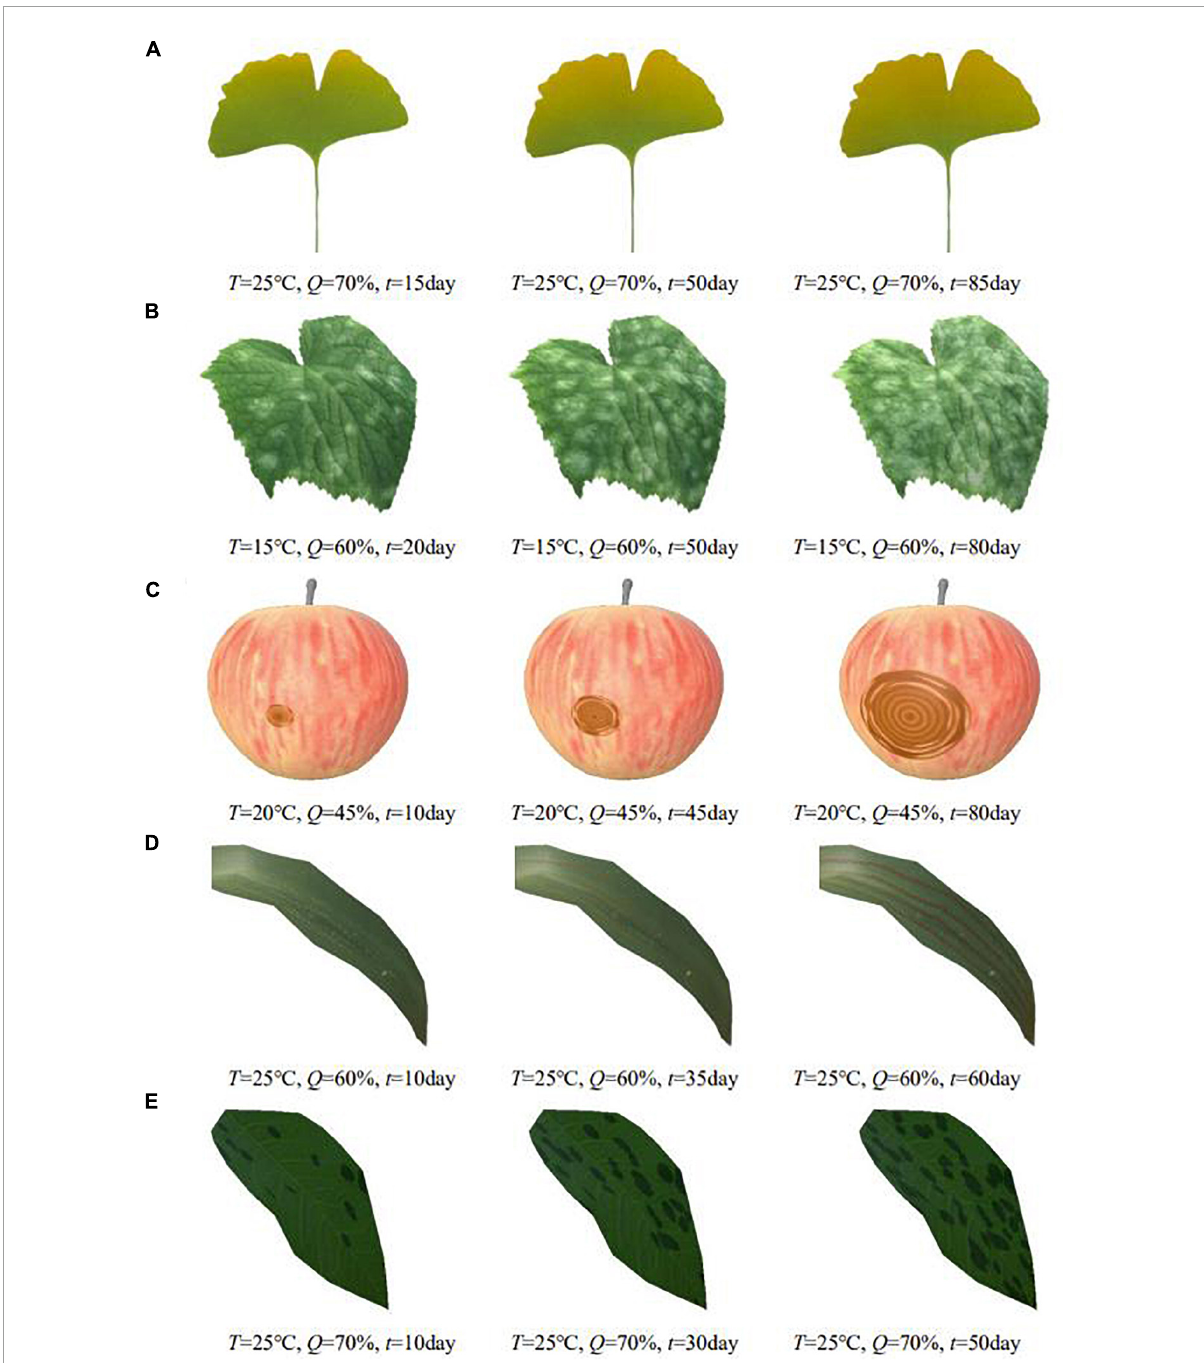
FIGURE9 Simulation results of different plant diseases under different parameters control. (A) Ginkgo yellows, (B) cucumber powdery mildew, (C) apple ring rot, (D) wheat stripe rust, (E) rose black spot.